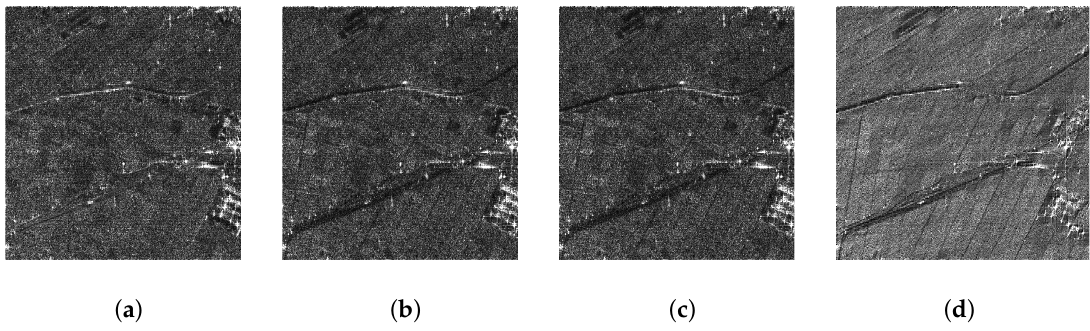
Figure 3. An example of TF decomposition result ( Q = 4). ( a ) sub-image 1; ( b ) sub-image 2; ( c ) sub-image 3; and ( d ) sub-image